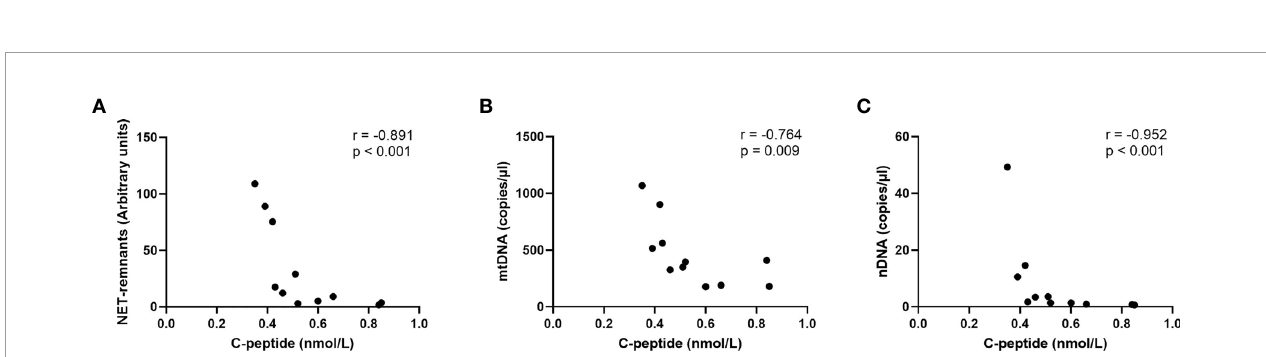
FIGURE 6 | Correlations for NETs (A) , mtDNA (B) and nDNA (C) with c-peptide in the last sample before onset in children who progressed to T1D (Spearman